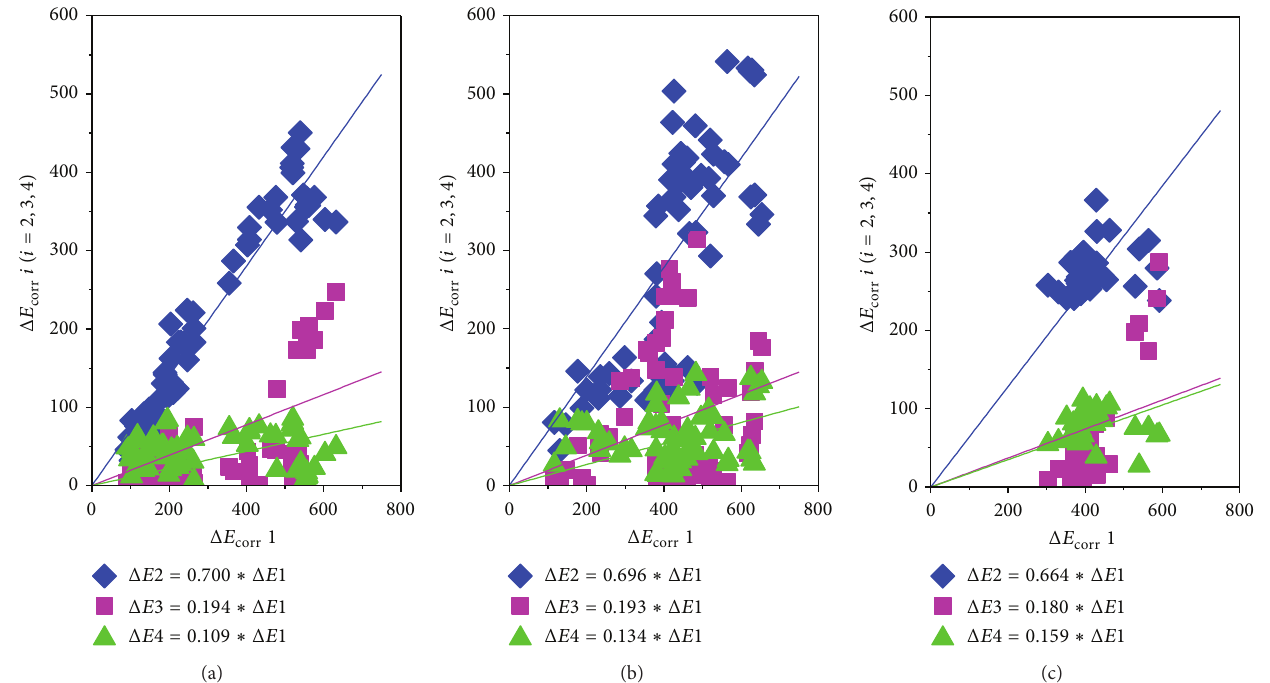
𝑖 ( 𝑖 = 2, 3, 4 ). (a) Water-cement ratio = 0.45, (b) water-cement ratio = 0.6, and (c) 1 and Δ𝐸 corr corr